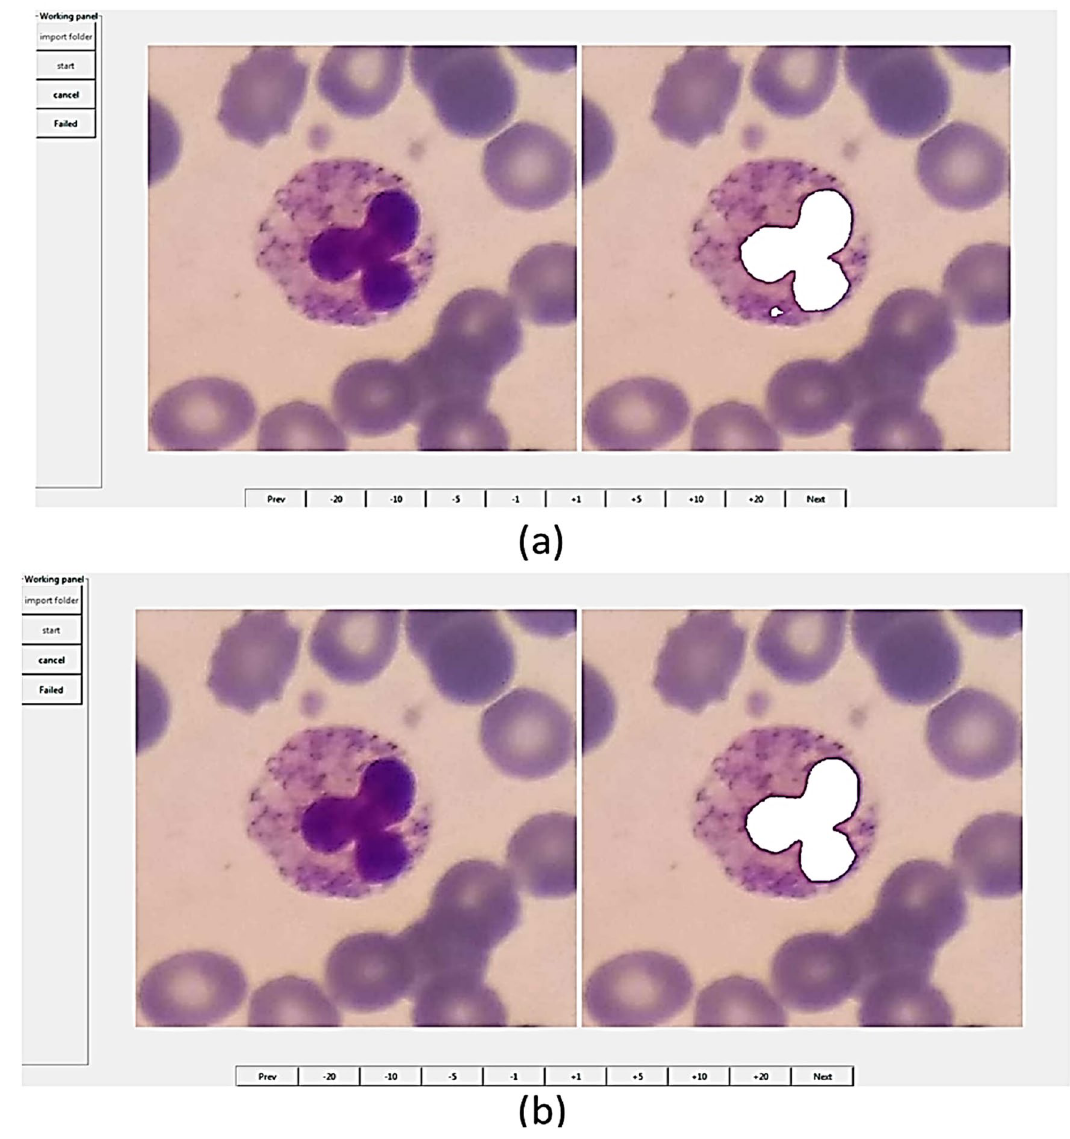
Figure 10. The user interface of Easy-GT software 41 . This software was developed for extracting the ground truths of nuclei in white blood